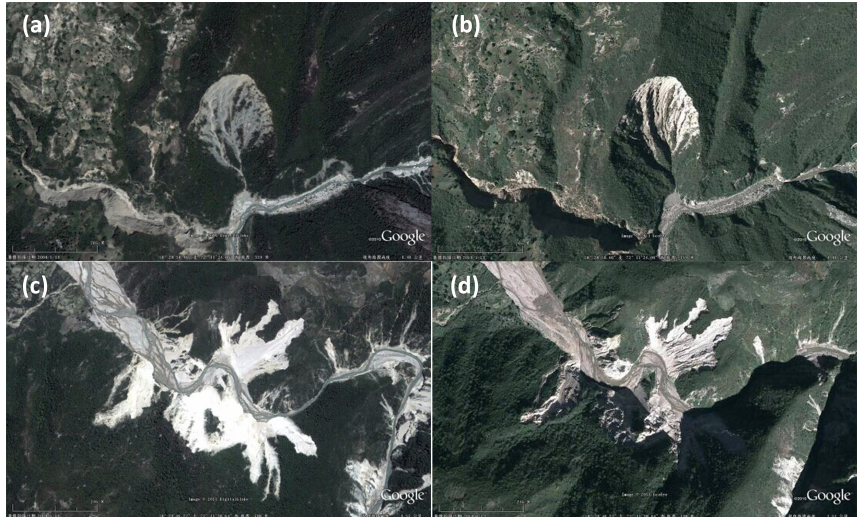
Figure 3. Pre-earthquake landslides are shown in two locations. (a) and (b) are located at 18 ◦ 29 0 02.70 00 N, 72 ◦ 11 0 22.28 00 W; (c) and (d) are located at 18 ◦ 29 0 46.48 00 N, 72 ◦ 11 0 37.86 00 W. (a) and (c) were taken on 10 May 2008 and (b) and (d) were taken on 13 January 2010.